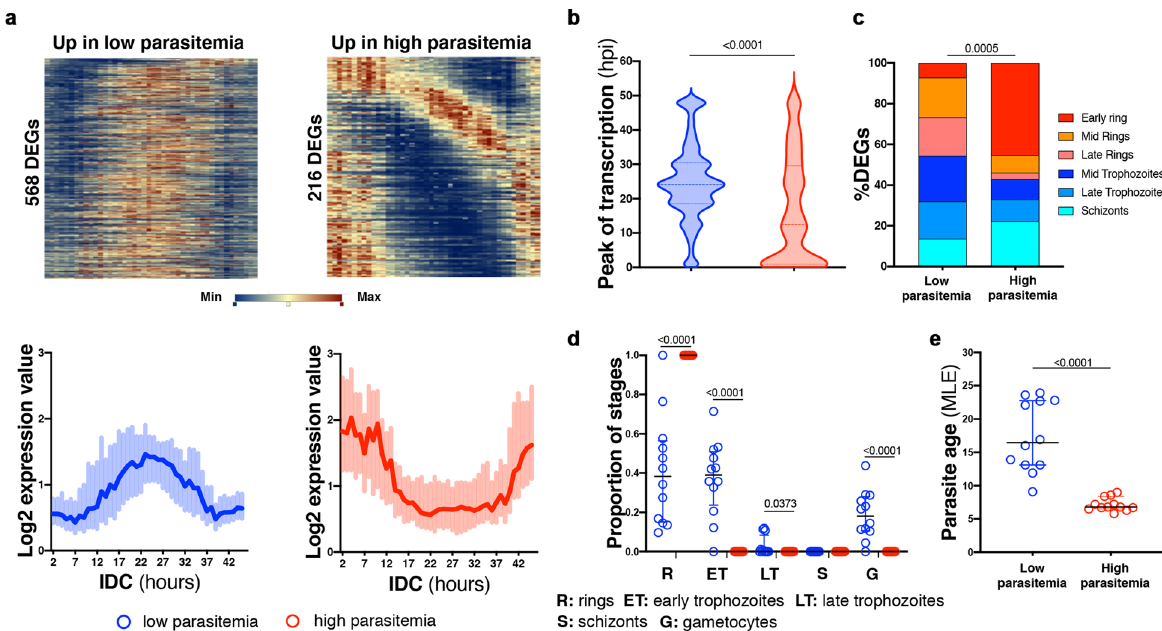
Fig. 2 Parasite circulation time drives transcriptional differences between asymptomatic dry season infections and mild malaria-causing parasites in the wet season. a Heatmaps (top) and log 2 expression value curves (bottom) in the P. falciparum HB3 reference along the ~48 h IDC in vitro according to Bozdech et al. 20 of Andrade et al. DEGs upregulated in low parasitaemias at the end of the dry season (left, n = 568, 50.22% of the total 1131 DEGs) and upregulated in high parasitaemias in malaria cases in the wet season (right, n = 216, 45.38% of the total 476 DEGs). For log 2 expression value curves (bottom) data indicate median ± IQR. b Time of peak transcription in hours post invasion in P. falciparum HB3 reference along the ~48 h IDC in vitro according to Painter et al. 24 of DEGs upregulated in low parasitaemias at the end of the dry season ( n = 971, 85.85% of the total 1131 DEGs), and DEGs upregulated in high parasitaemias in malaria cases in the wet season ( n = 397, 83.40% of the total 476 DEGs). Data indicate median ± IQR; two-tailed Mann – Whitney test, p < 0.0001. c Predicted stage composition according to Painter et al. 24 of DEGs upregulated in low parasitaemias at the end of the dry season ( n = 857, 75.77% of the total 1131 DEGs) and DEGs upregulated in high parasitaemias in malaria cases in the wet season ( n = 221, 46.43% of the total 476 DEGs). Two-tailed Fisher ’ s exact test of DEGs assigned to developmental stages. d Predicted proportion of ring, early trophozoite, late trophozoite, schizont, and gametocyte stages according to Tonkin-Hill et al. ’ s mixture model 17 using whole transcriptome data from low parasitemia samples from the dry season (blue, n = 12) and high parasitemia samples from malaria cases in the wet season (red, n = 12), One-way ANOVA with Sidak multiple comparisons test. e Maximum likelihood estimation (MLE) according to Lemieux et al. 16 of parasite age in hours post invasion of low parasitemia samples from the dry season (blue, n = 12) and high parasitemia samples from malaria cases in the wet season (red, n = 12). Data indicate mean ± SD; two-tailed Mann – Whitney test, p <